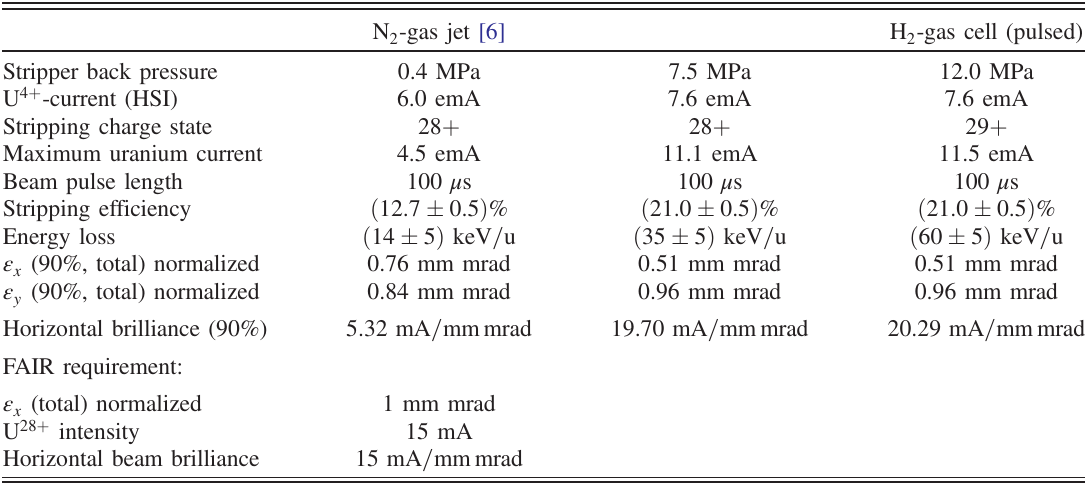
TABLE I. Measured beam